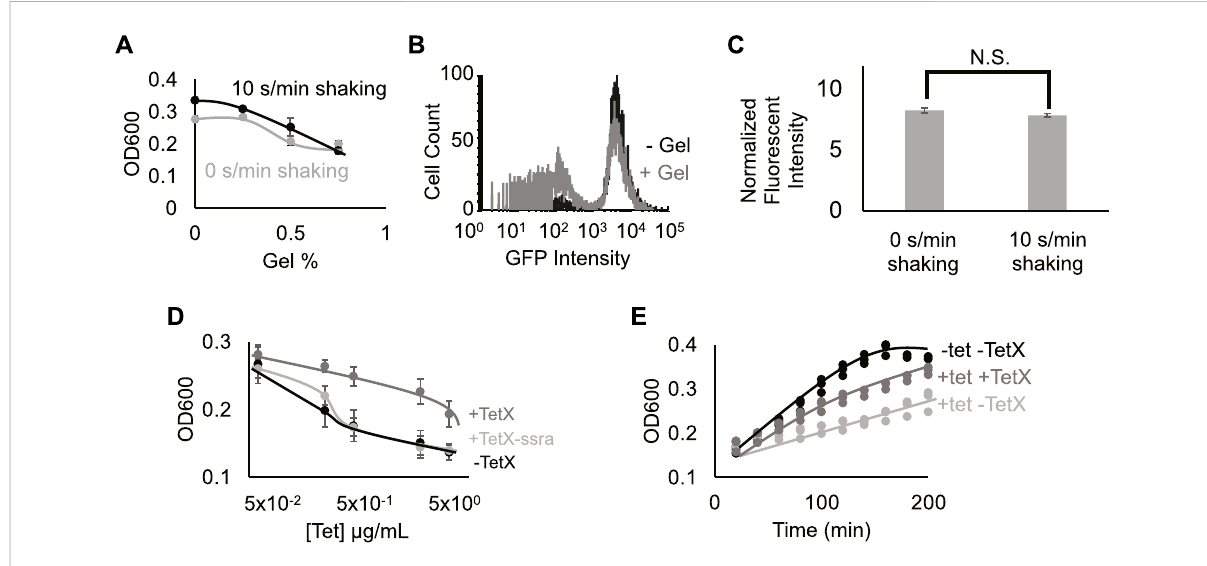
FIGURE 2 Hydrogel encapsulation imparts gene expression heterogeneity. (A) Cell density in different gel density environments at 2 h 0%, 0.25%, 0.5%, and 0.75% gel density with 10 s/min shaking (black line) or with 0 s/min shaking (grey line). Increased hydrogel density reduces bacterial growth. Points represent mean values, and error bars represent standard error of the mean. Mean and SEM are calculated using six biological replicates. (B) Fluorescence intensity distribution of cells expressing TetX-GFP fusion protein in media containing 0% (black line) and 0.5% low-melting- temperature agarose (grey line). Results demonstrate that hydrogel-encapsulation limits the expression of TetX-GFP in a subset of bacteria. One of tworeplicatesshownforeachcondition, refertoSupplementary.FigureS4forbothreplicates. (C) Fluorescenceintensity ofTetX-GFPnormalizedby OD600 of cells after 2 h of growth with either 0 s/min or 10 s/min shaking. Mean expression levels are not signi fi cantly different. Two-tailed, equal variance t -testreturns p -value=0.189.N.S.standsfor “ notsigni fi cant ” .Barheightrepresentsmeanvalues,anderrorbarsrepresent standarderrorof the mean. Mean and SEM are calculated using eight biological replicates. (D) Cell density of resistant and non-resistant DH5 α cells under different concentrations of tetracycline. +TetX-ssra (light grey line), +TetX (grey line) and -TetX (black line). Results show that TetX rescues bacterial growth from tetracycline repression. Points represent mean values, and error bars represent standard error of the mean. Mean and SEM are calculated using six biological replicates. (E) Cell density of resistant bacteria (TetX) in different tetracycline (tet) over time. 0.625 µg/ml tetracycline on DH5 α cells without TetX (light grey line), 0.625 µg/ml tetracycline on DH5 α cells without TetX (grey line) and 0 µg/ml tetracycline on DH5 α cells without TetX (black line). Results show that tetracycline inhibition of cellular growth is re fl ected by decreased rates of growth over time, and rescue by TetX